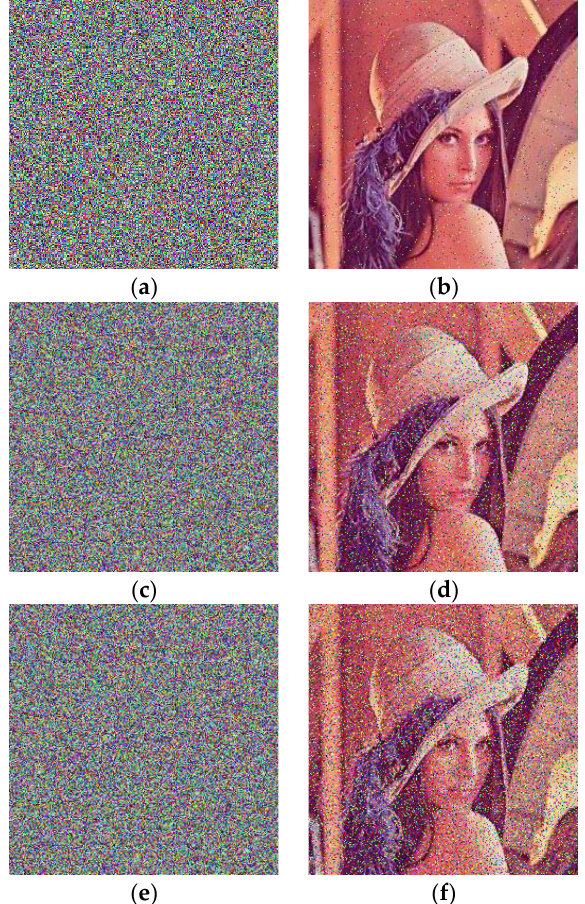
Figure 11. Noise experiment adding noise intensity of ( a ) 0.02, ( b ) 0.12, and ( c ) 0.2 after the encrypted image, and ( d – f ) is their corresponding decryption image.